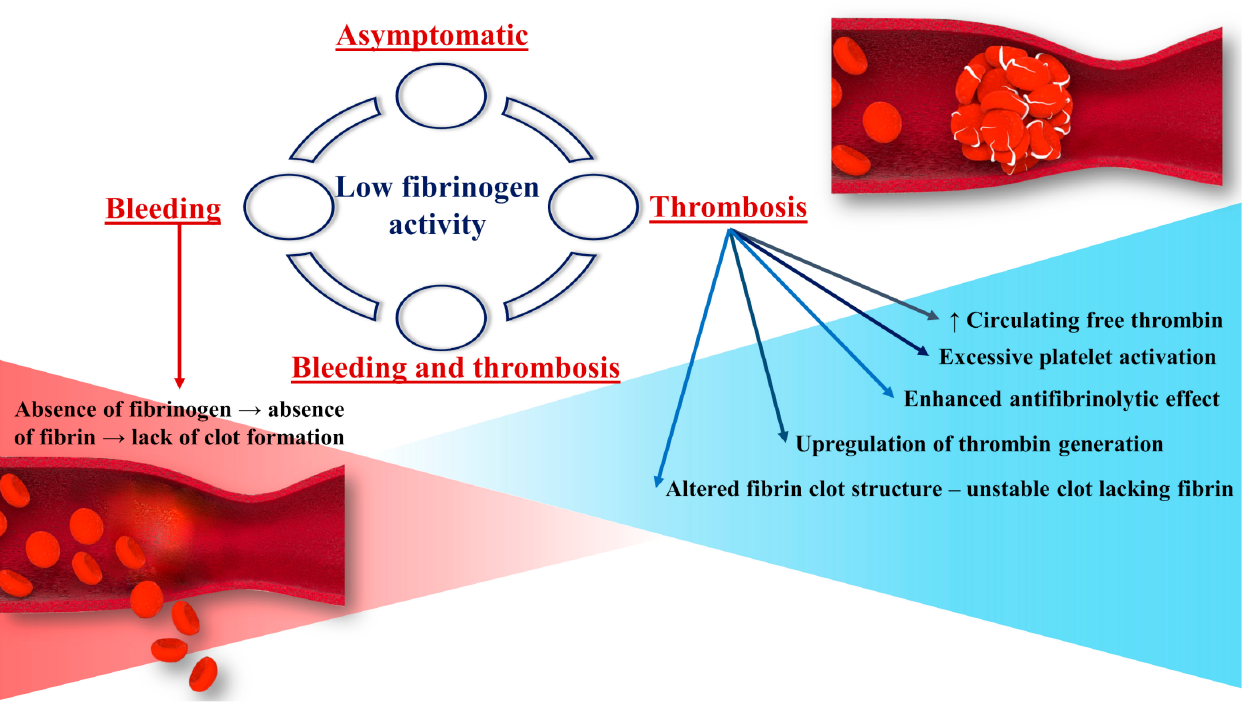
Figure 2. Pathogenesis of thrombosis and bleeding in association with low fibrinogen activity. Fibrinogen mediates the modulation of coagulation and fibrinolysis through thrombin binding, conferring antithrombin activity, and through FXIII, plasminogen,